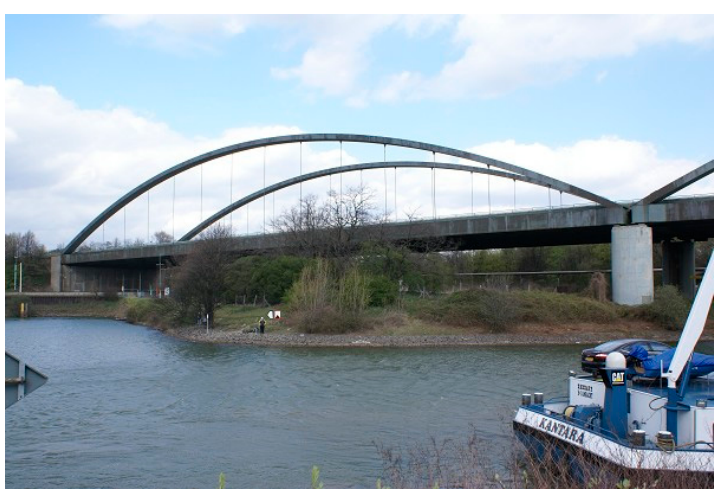
Figure 2. Bridge for the Autobahn A-42. Rhine–Herne Canal. Photo: N. Janberg (reproduced with permission from Structurae [7], 2008).